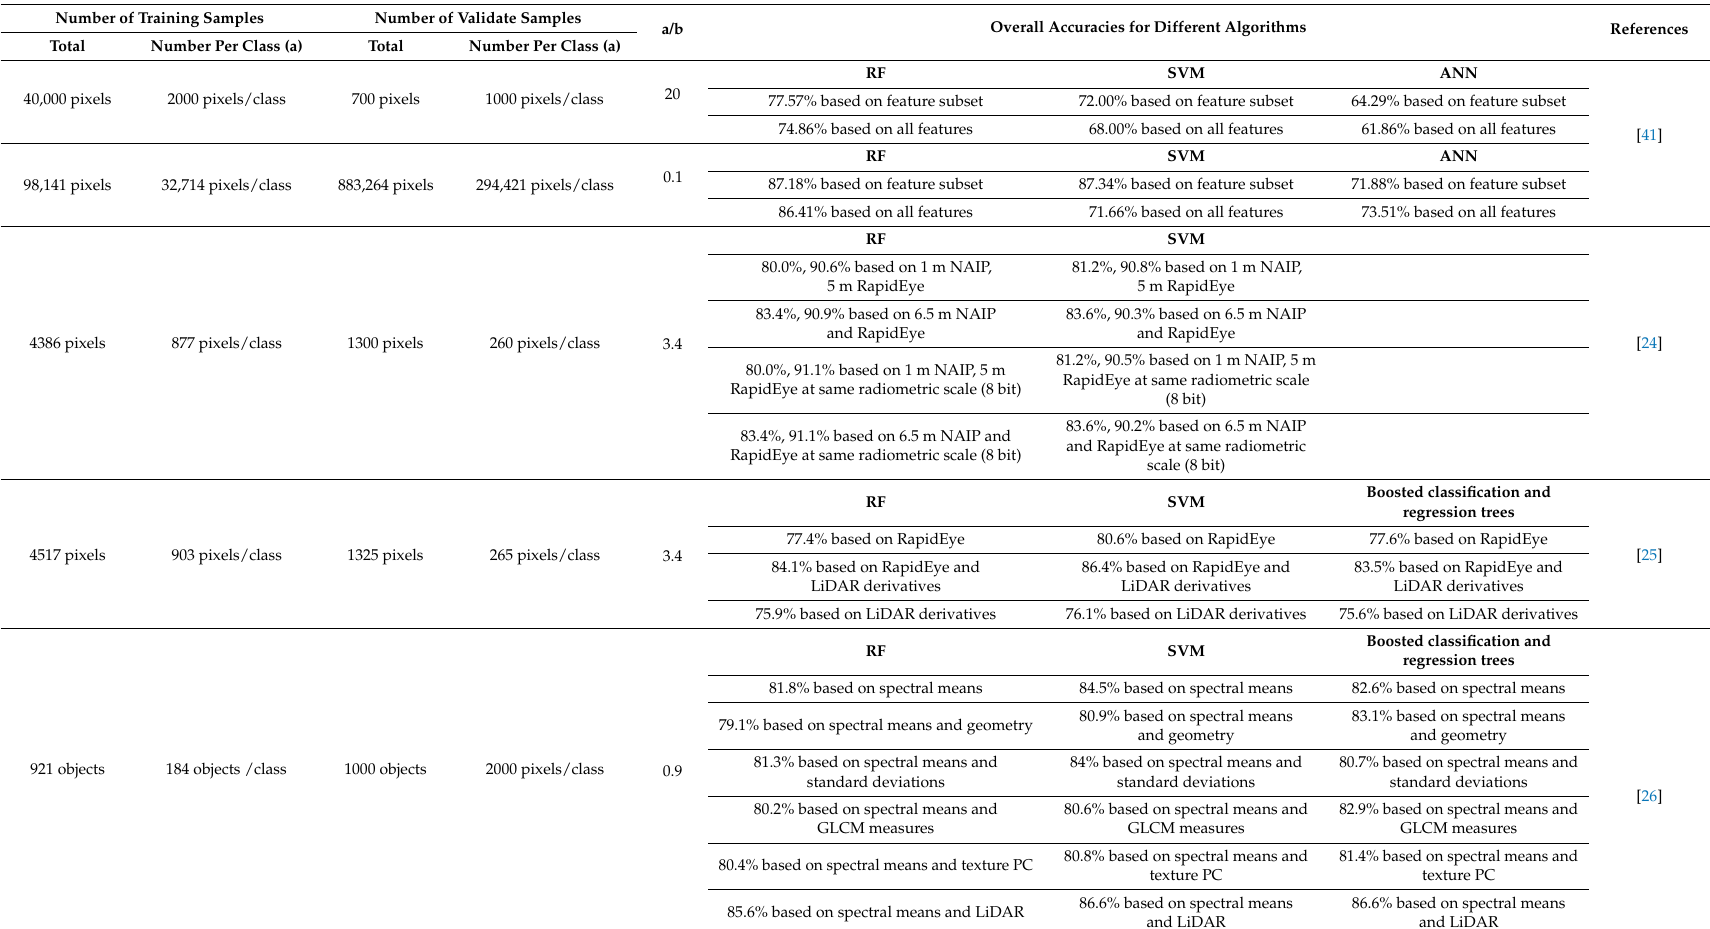
Table 4. The relationship between the number of samples used to train and validate the machine-learning classification algorithms and overall accuracies for different algorithms in related to